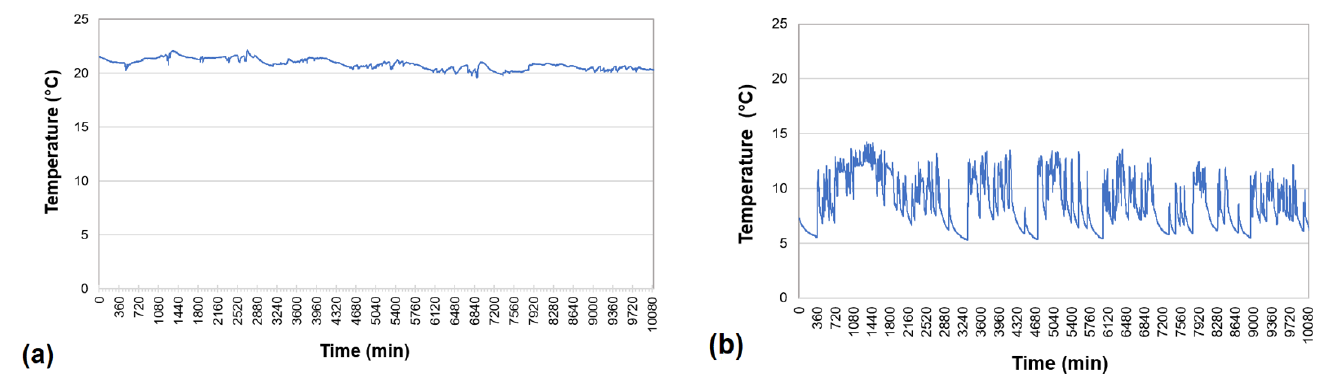
Figure 11. Changes in temperature of the treated wastewater in sample weeks of ( a ) the summer period and ( b ) the winter period.